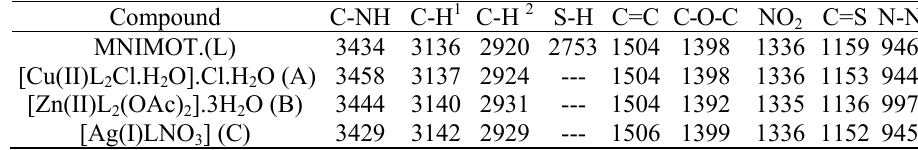
Table 3. Major IR bands of ligand(MNIMOT) and its metal complexes